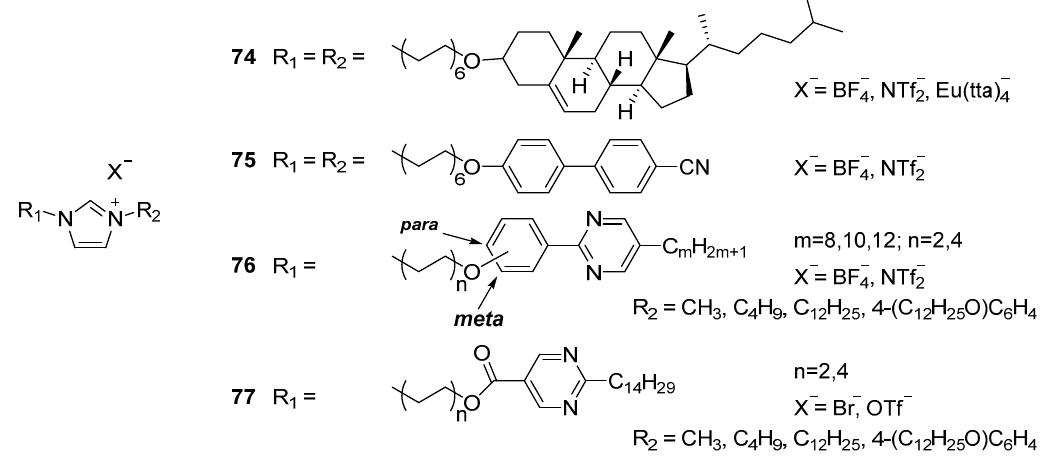
Figure 18. Imidazolium-based ILCs with traditional mesogens or mesogen-like moieties attached to the cation through a flexible spacer that decouples the two entities. the cation through a flexible spacer that decouples the two